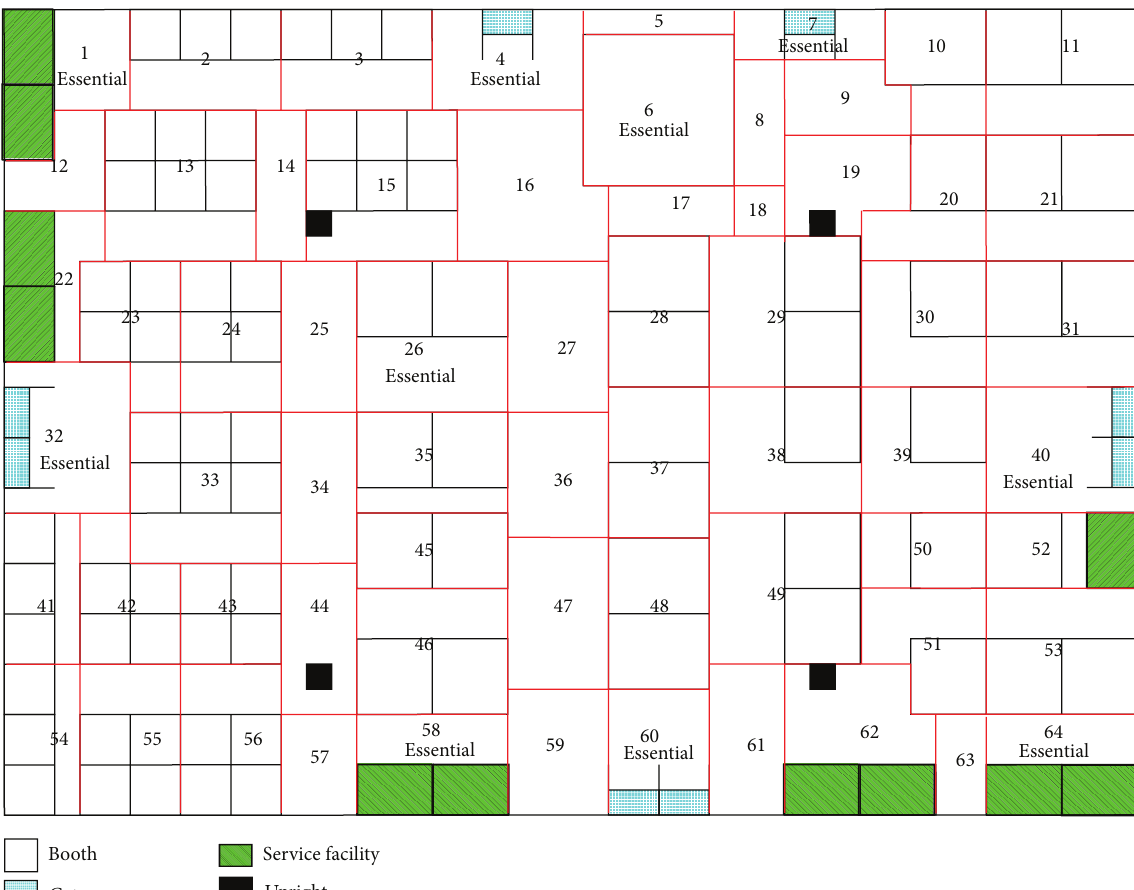
Figure 6: The result of surveillance scene